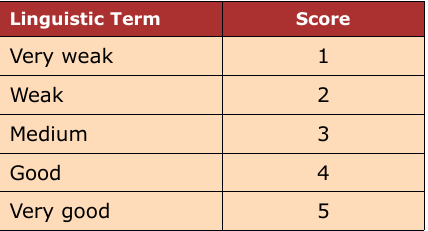
Table 7. Linguistic scale for